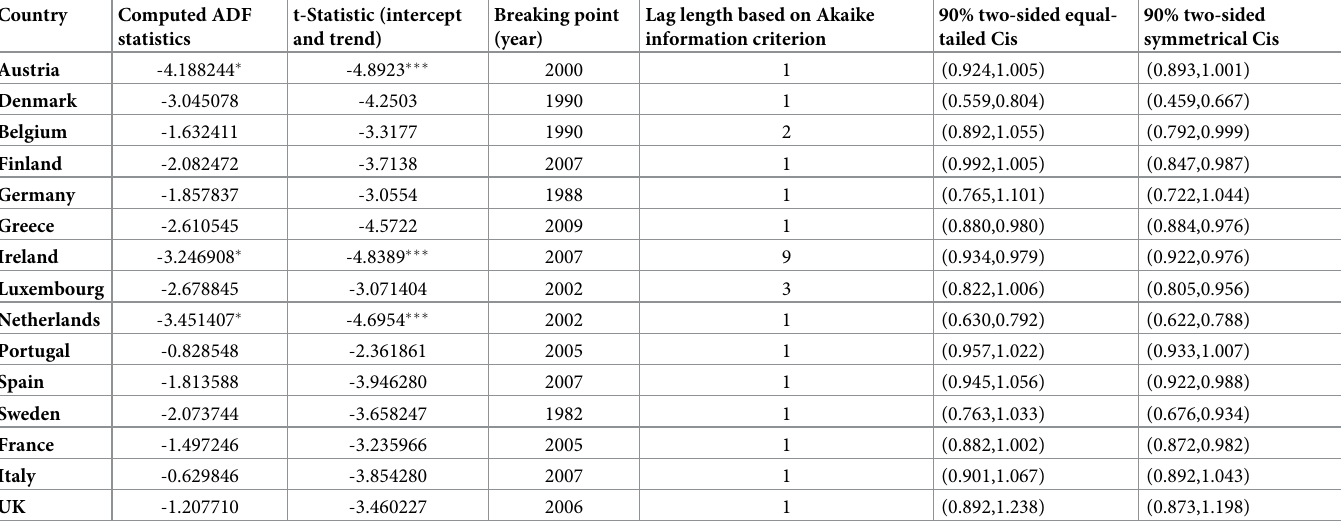
Table 4. Results of univariate ADF and structural break-accounting Zivot-Andrews tests and subsampling confidence intervals for EU-15 countries